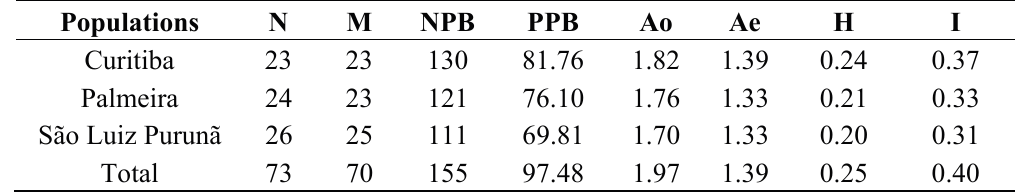
Figure 3. Principal components analysis from 73 individuals of S. lachnostachys collected on three locations in the Parana State, Brazil. Table 2. Genetic diversity of three populations of Salvia lachnostachys Benth. (Lamiaceae). Populations